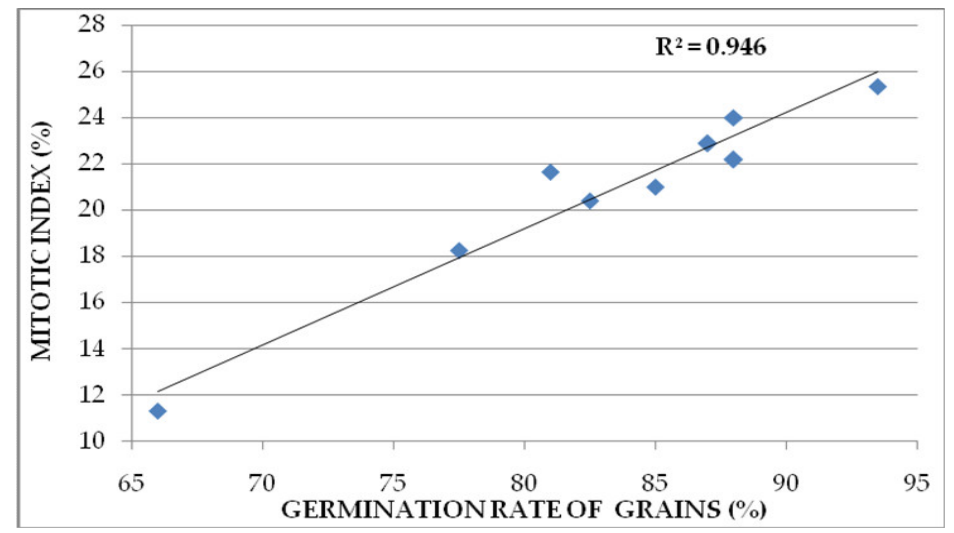
Figure 3. Correlation between germination rate of grains and mitotic index.